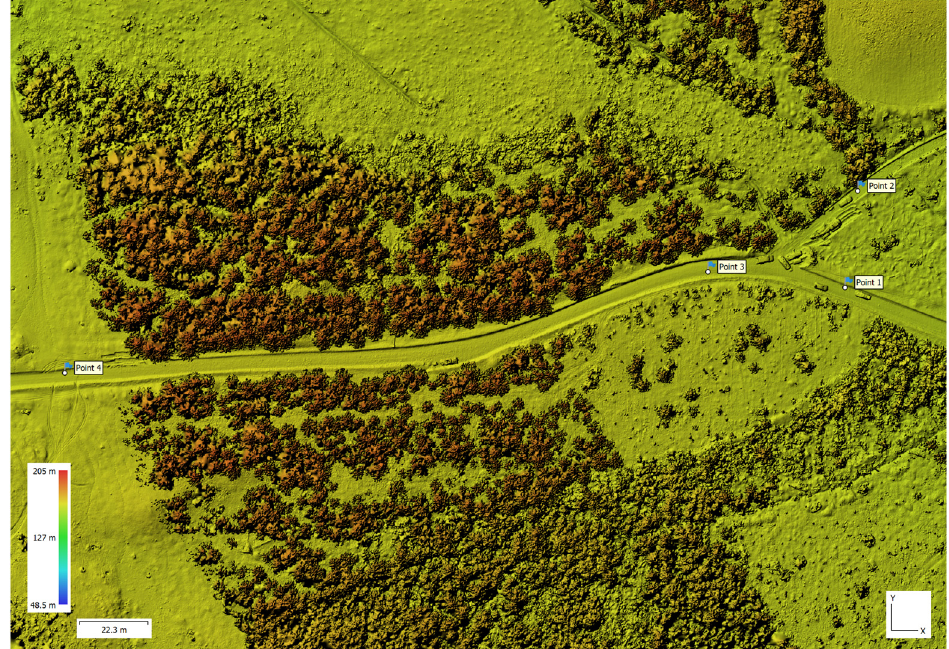
Figure 3. The digital surface model reconstructed using structure-from-motion process and several ground control points.